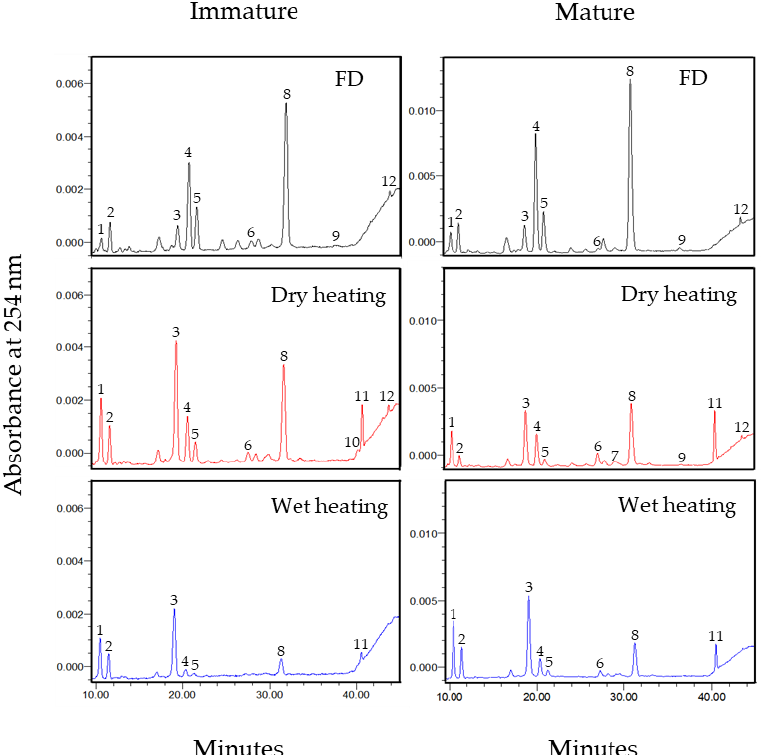
Figure 3. Twelve isoflavones of immature and mature soybean seeds after 120 min of dry- and wet-heat treatment determined by HPLC. 1, daidzin (DZI); 2, glycitin (GLI); 3, genistin (GNI); 4, malonyldaidzin (MDZI); 5, malonylglycitin (MGLI); 6, acetyldaidzin (ADZI); 7, acetylglycitin (AGLI); 8, malonylgenistin (MGNI); 9, daidzein (DZE); 10, glycitein (GNE); 11, acetylgenistin (AGNI); 12, genistein (GNE). Of the three types of malonylglycoside isoflavones, MGNI (78.18 mg/100 g DW in immature soybeans; 141.25 mg/100 g DW in mature soybeans) and MDZI (62.32 mg/100 g DW in immature soybeans; 119.20 mg/100 g DW in mature soybeans) were the main isoflavones in the FD samples (Tables 2 and 3). The deglycosylation of MGNI, MDZI, and MGLI was more severe after wet-heating than after dry-heating regardless of the level of the seed maturity. Significantly positive correlations ( p < 0.001) between the contents of MGNI, MDZI, and MGLI individually and of TIMG were observed in all the samples (Table 4). The contents of the three types of malonyl isoflavone in the immature soybeans did not change after 30 min of dry-heating but drastically decreased after 30 min of wet-heating. Similar results have also been observed by Chien et al. [34], where moist-heating at 100 °C reduced the MGNI (standard compound) content more than dry-heating at 100 °C.